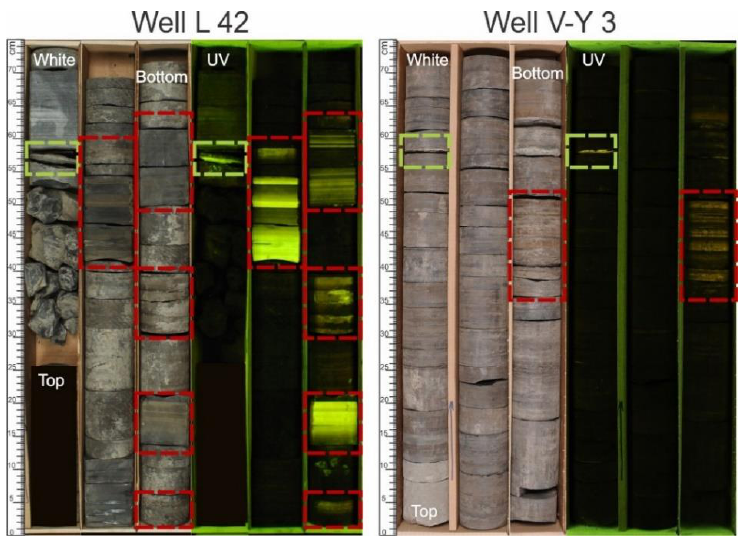
Figure 3. Core layout showing typical appearance of the Bazhenov Formation organic-rich siliceous rocks with presence of the alginite-rich layers (marked in red) and tuffs (marked in light green). Core photographs under white and UV light.